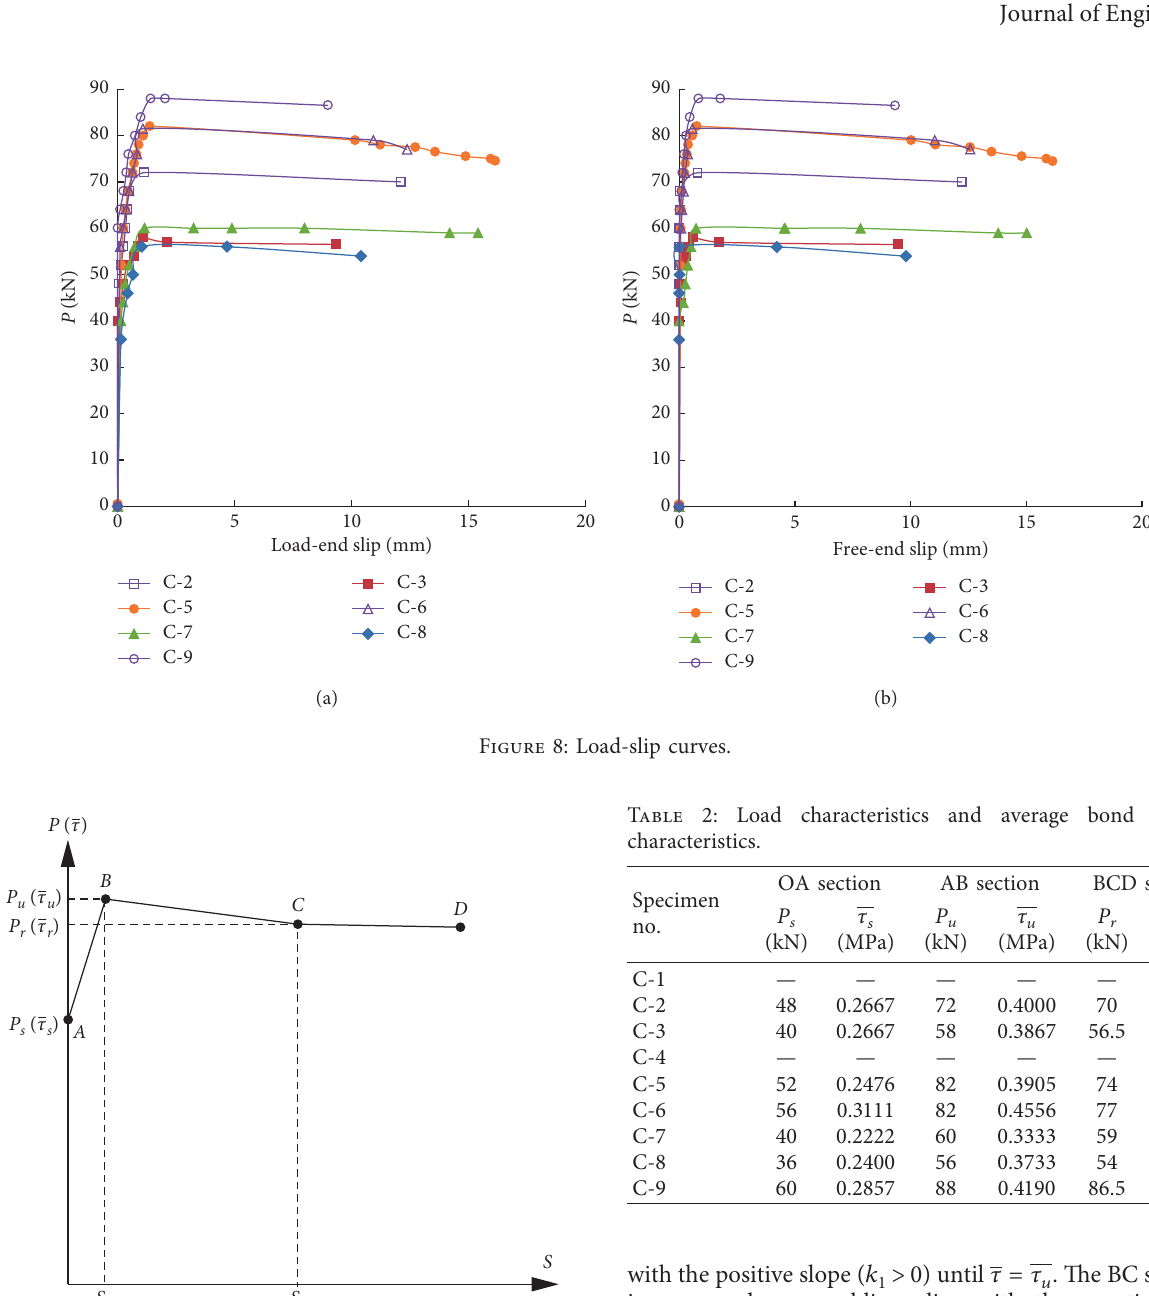
Figure 9: Typical constitutive relationship curve.